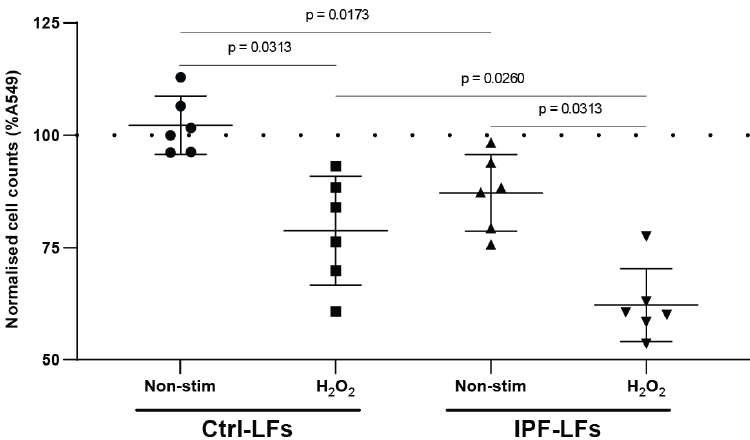
Figure 1. Senescent LFs reduce proliferation of A549 cells in co-culture. A549 cells were co-cultured in the presence of Ctrl-LFs ( n = 6) or IPF-LFs ( n = 6). Fibroblast senescence was induced by stimulation with 150 µ M H 2 O 2 for 2 h followed by incubation for 72 h in low-serum DMEM, and afterwards co-cultured for 48 h. Proliferative potential of A549 cells was measured by cell enumeration. All data were normalized to A549 cell baseline growth (dotted line, 100%) and expressed as mean ± SD, p < 0.05 was considered statistically significant, Wilcoxon matched-pairs rank test for non-stimulated and H 2 O 2 ; Mann–Whitney U for Ctrl-LFs vs. IPF-LFs at baseline. Table 1. Characteristics of fibroblast donors used in this study. N/A = data not available. Mean age of non-ILD donors 54 years and IPF donors 59 years of age. Fibroblast samples were chosen at random for any